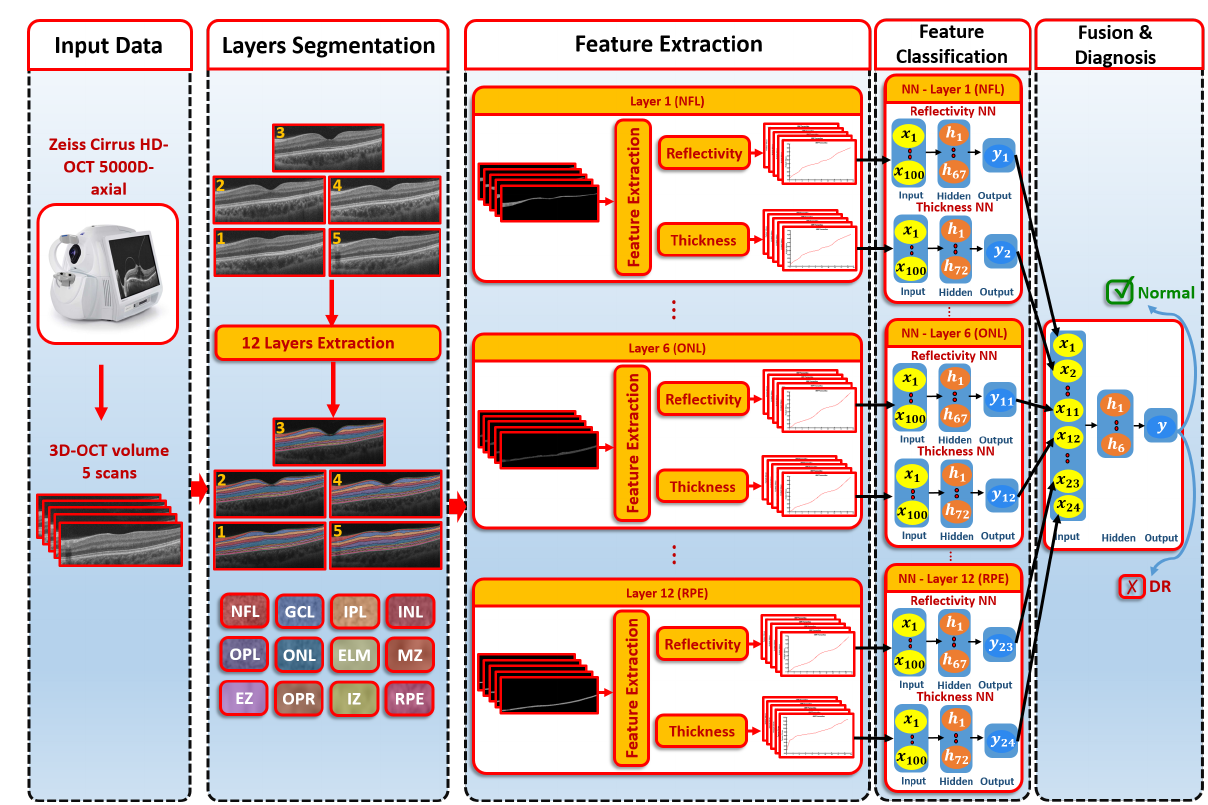
Figure 1. An illustration of the proposed 3D-OCT technology for DR diagnosis.